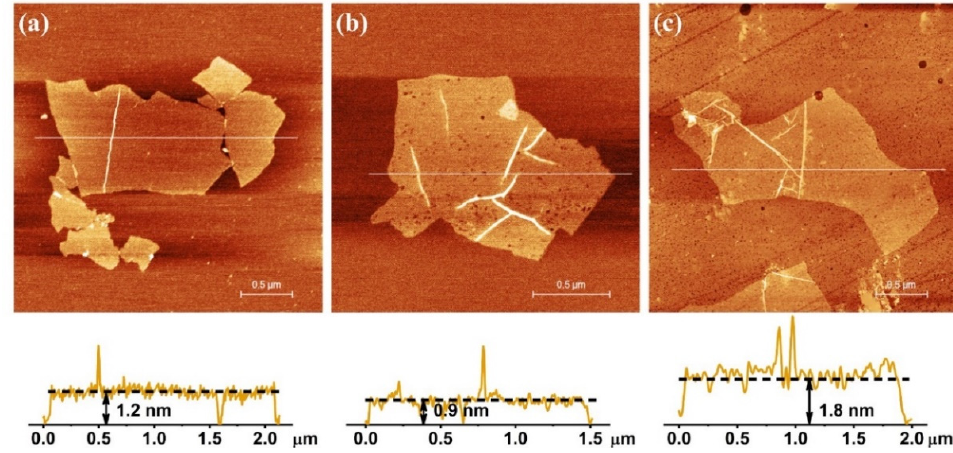
Figure 7. AFM images of ( a ) GO 3.0 g, ( b ) GO 4.5 g and ( c ) GO 6.0 g samples, and its respectively height profiles.